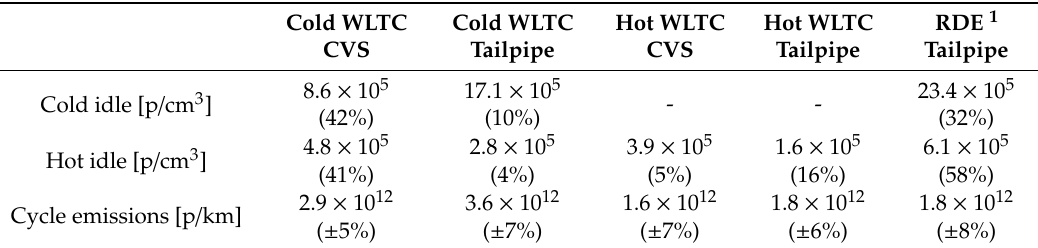
Table 2. Results for the vehicle presented in Figure 2. Numbers in brackets give one standard deviation or half of max-min when two repetitions were available. Number of repetitions (n): n = 4 for cold WLTC and RDE, n = 2 for hot WLTC. CVS = Constant Volume Sampling (dilution tunnel); RDE = Real-Driving Emissions test; WLTC = Worldwide harmonized Light vehicles Test